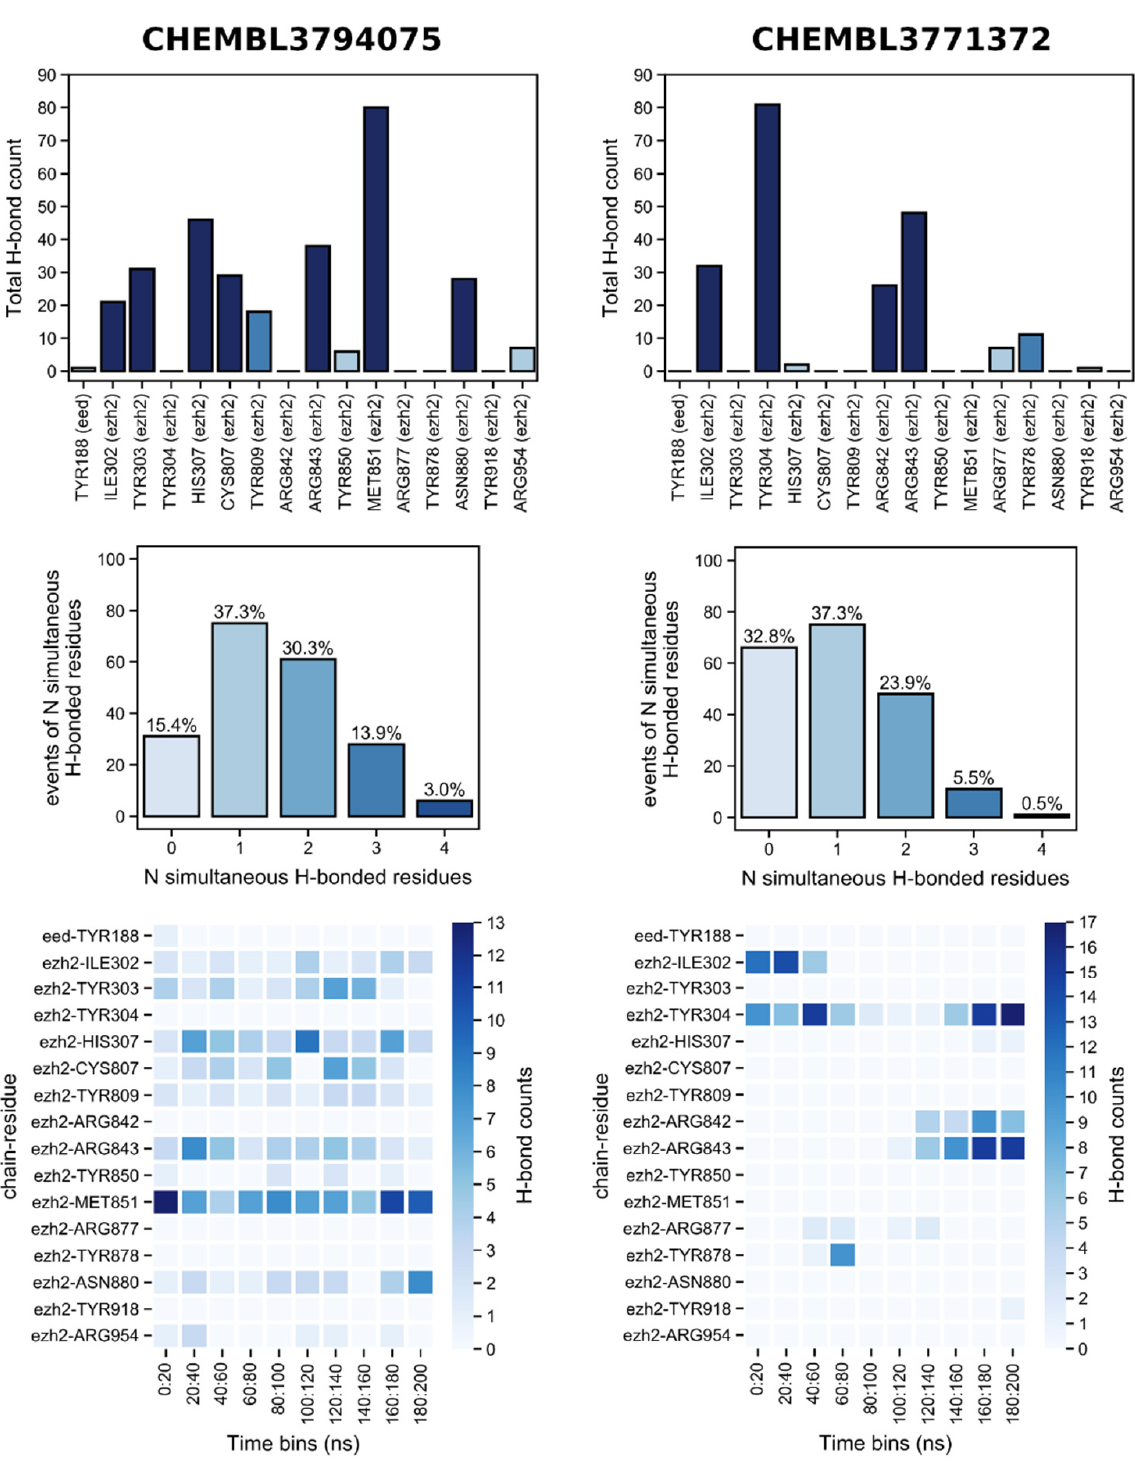
Figure 19. Hydrogen bonds established with EZH2 by the two hit compounds obtained from docking, throughout the 200 ns simulation. For ease of visualisation, the bar plot of total H-bond counts shows higher counts in increasingly darker blue: <10 H-bonds (light blue), 10–20 H-bonds (medium blue), >20 H-bonds (dark blue).